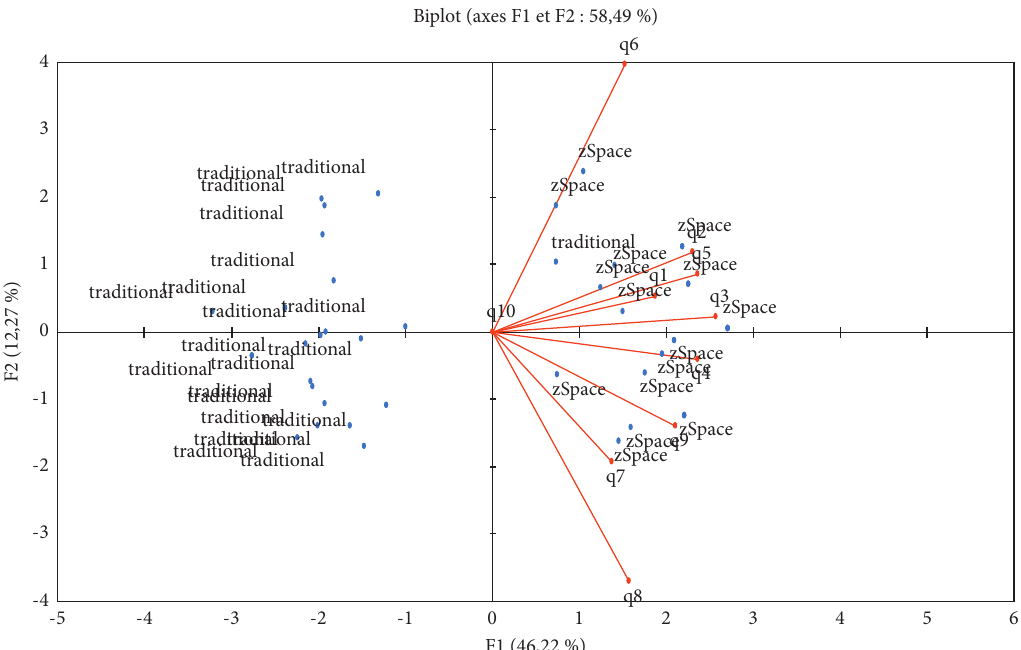
Figure 6: Common representation of the variables and the observations (the correlation between variables and its relationship with observation).